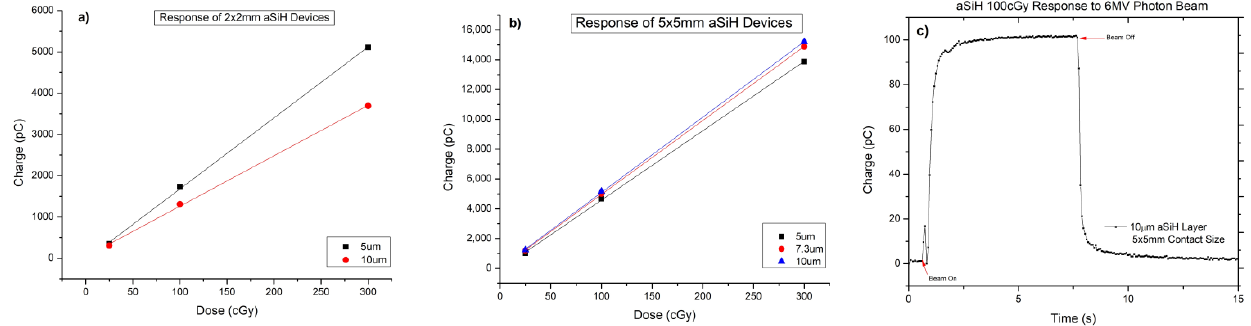
Figure 9. ( a ) Response of pad sensors with different thicknesses to 6 MV photon irradiation; ( a ) area of the sensor 2 × 2 mm 2 ; ( b ) area of the sensor 5 × 5 mm 2 ; ( c ) timing response of a 5 × 5 mm 2 10 µm-thick sensor.